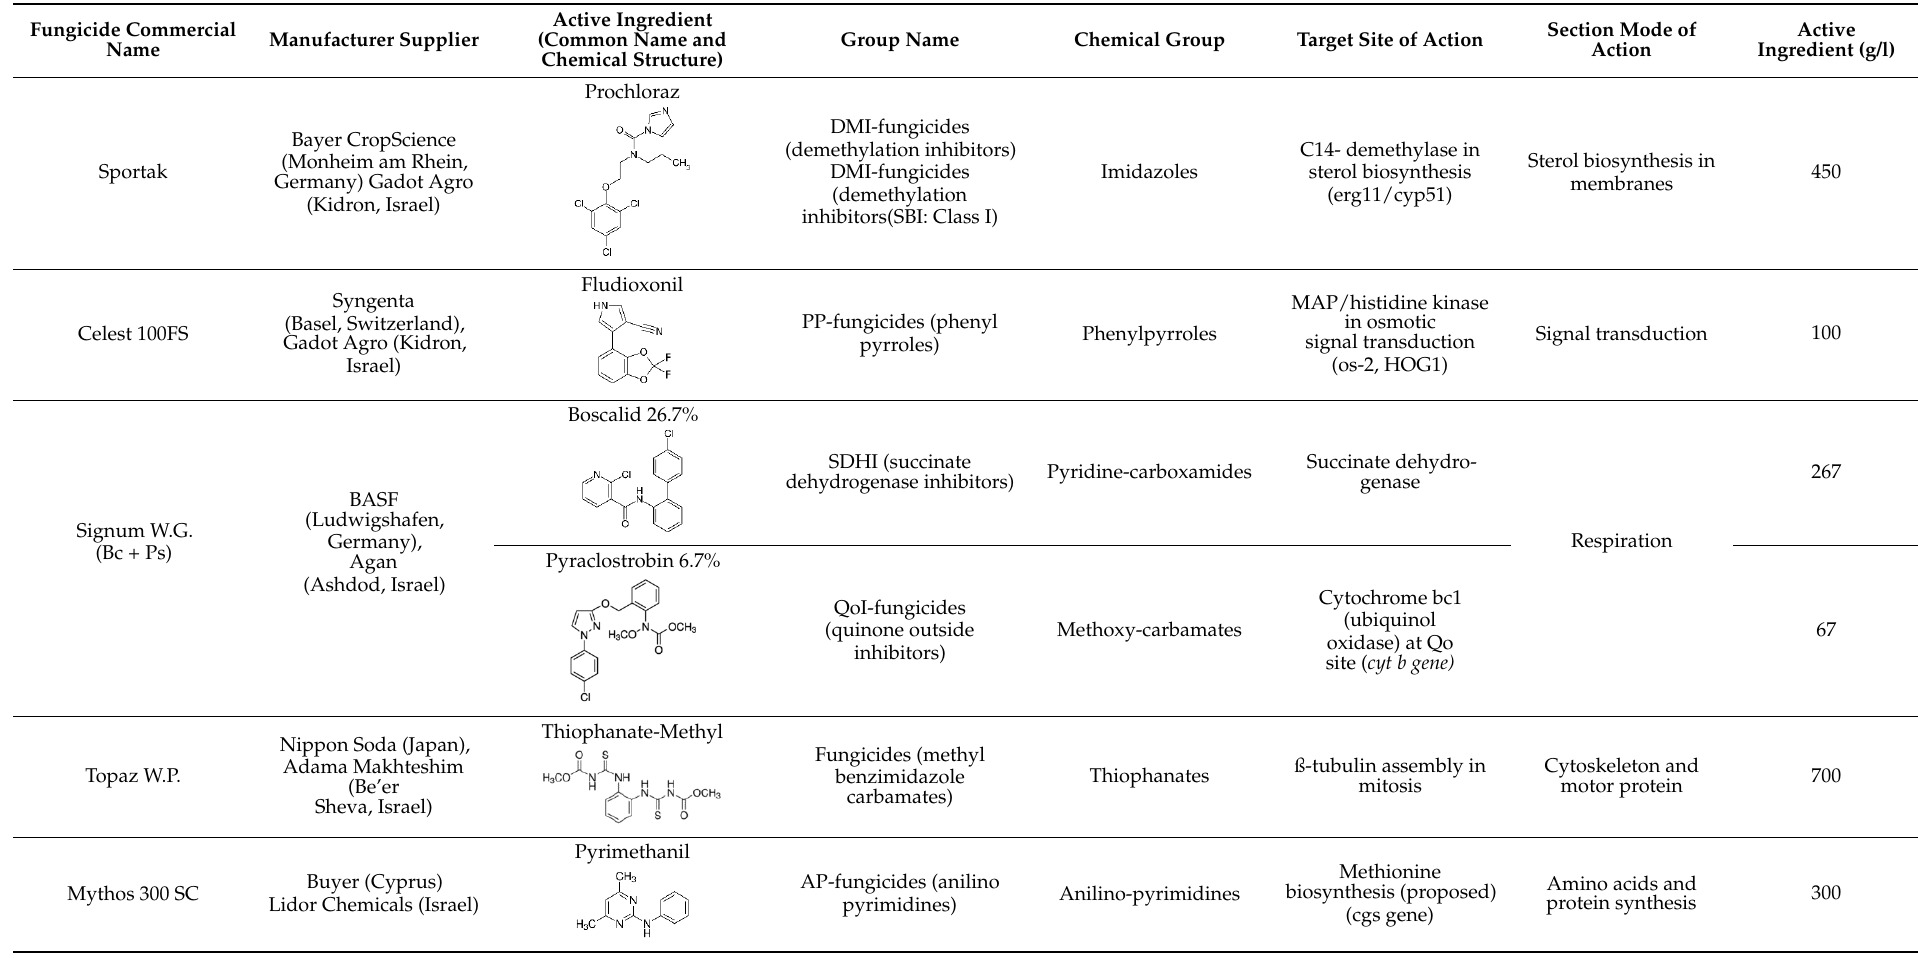
Table 2. Fungicides used in this study a .